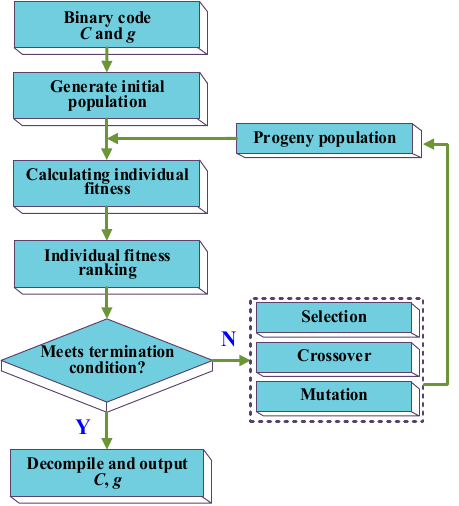
Figure 4. Optimizing process of genetic algorithm.